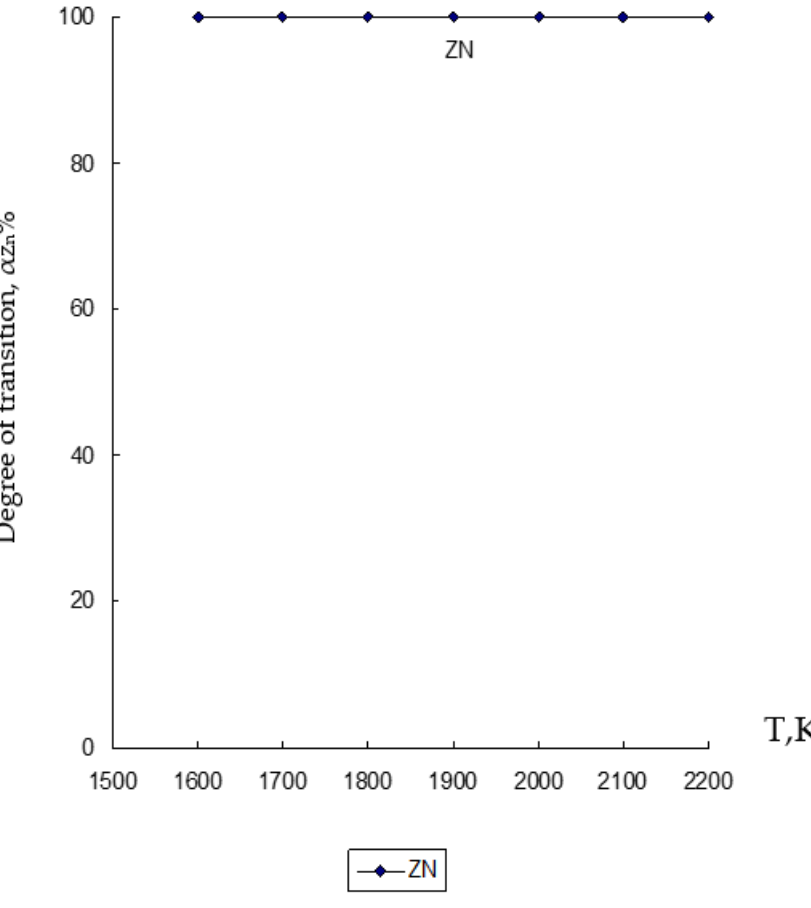
Figure 1. Micrography ( a ) and elemental analysis ( b ) of metallurgical waste.